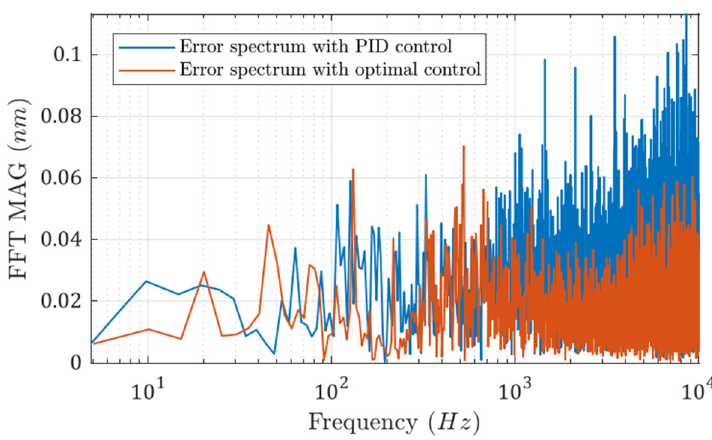
Figure 9. FFT spectra of the two error signals with different control algorithms.